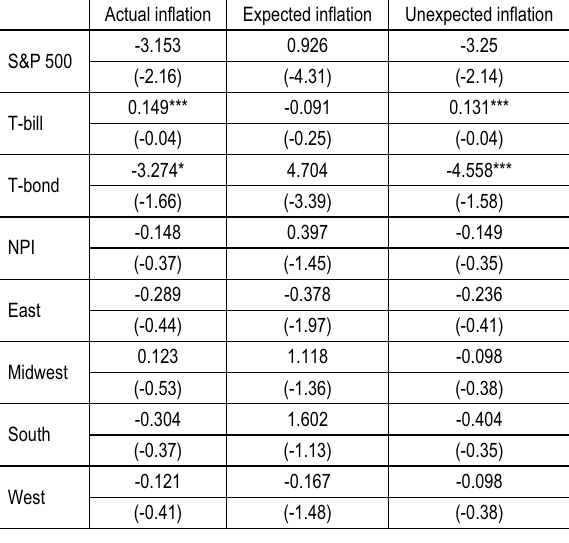
Table 5. First half of sample